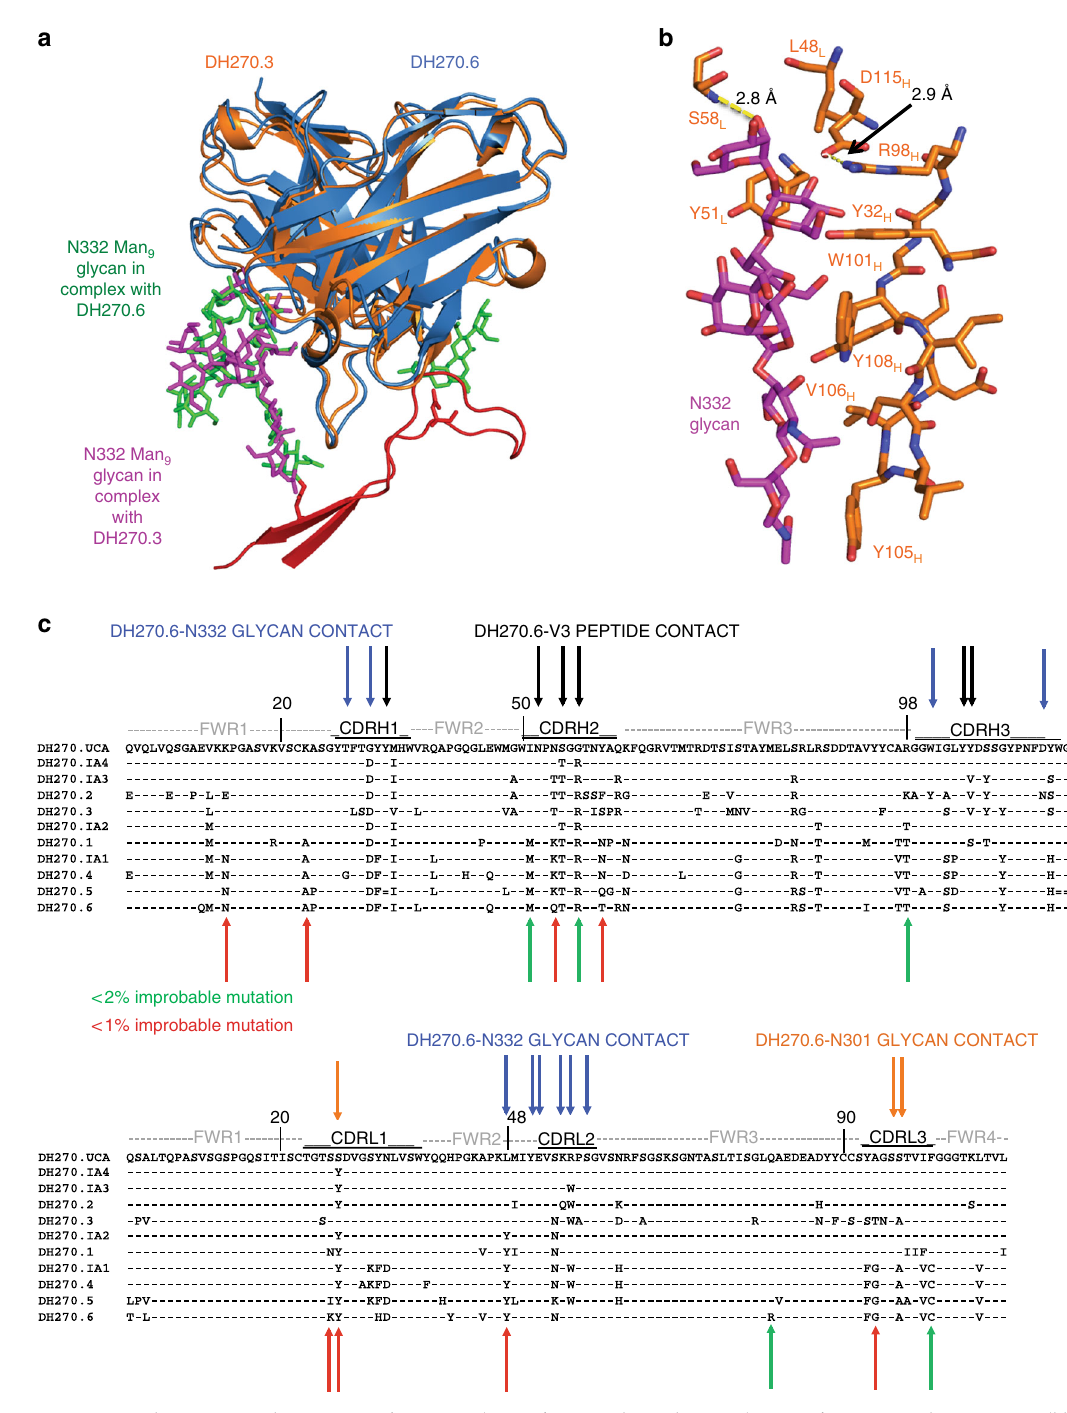
Fig. 5 DH270.3-Man 9 crystal structure. a The structure of DH270.3 (orange) in complex with Man 9 (magenta), superposed on DH270.6 (blue) in complex with Man 9 -V3 (red), with glycans shown as green sticks. b Contacts made by DH270.3 and Man 9 . c Sequence alignments of DH270 lineage members with glycan and peptide contact sites indicated. CDR loops, framework regions, and improbable mutations are also